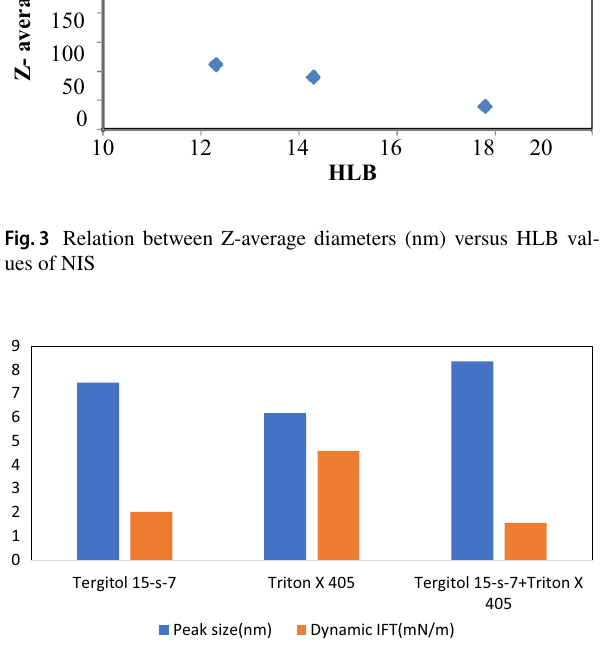
Fig. 4 Comparison of particle size diameter of the NIS/NISs w.r.t